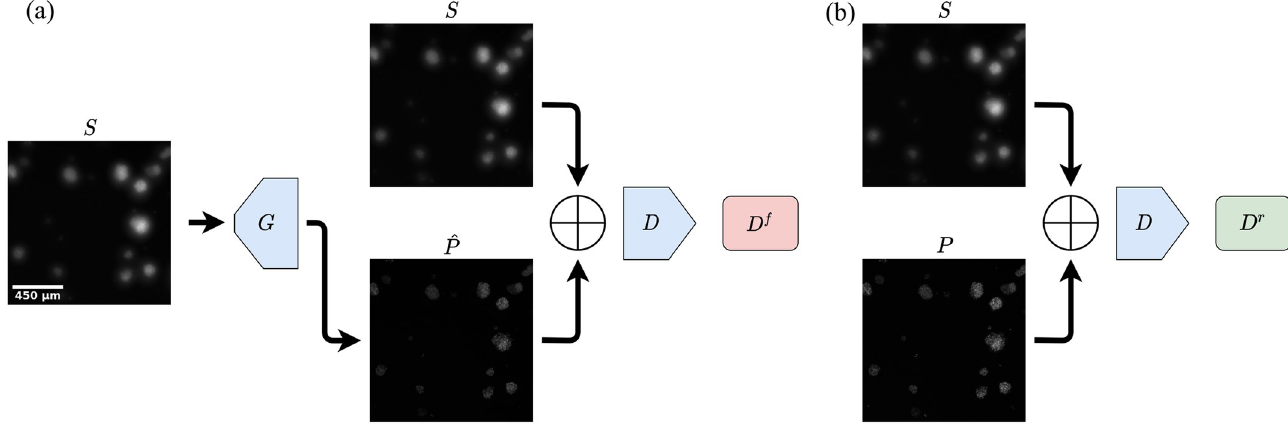
Fig 3. Schematic illustration of the conditional generative adversarial network (CGAN)-approach used to improve prediction of z-projection of images. � indicate stacking of the images. (a) During training, the generator G predicts a z-projection image ^ P based on the input sweep image S . S is stacked onto ^ P to create a two-channel image, which the discriminator D attempts to classify as fake D f . (b) To provide negative examples, real z-projection images P are similarly stacked with z-sweeps and the discriminator then attempts to classify them as real D r . The discriminator is optimized to accurately classify z-projection images as real or fake, while the generator network is optimized to make the discriminator prediction more difficult. The scale bar in the leftmost image applies to all